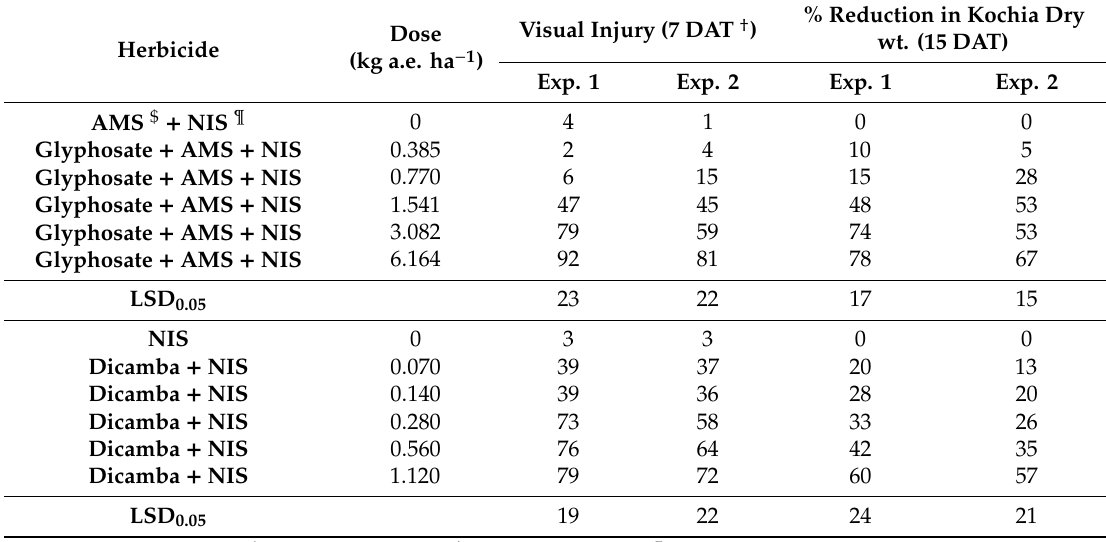
Table 2. Herbicide dose response of kochia grown on PCC piles averaged across three locations. Dose Herbicide (kg a.e. ha − 1